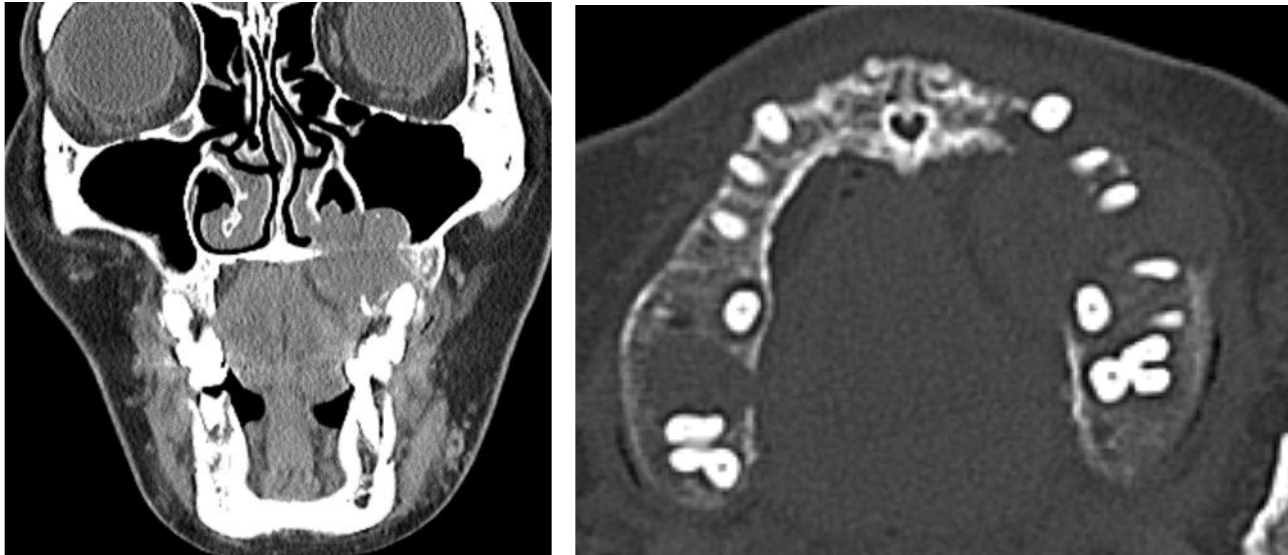
Figure 2. Preoperative contrast-enhanced computed tomography image presenting radiolucent lesion evading adjacent bone.